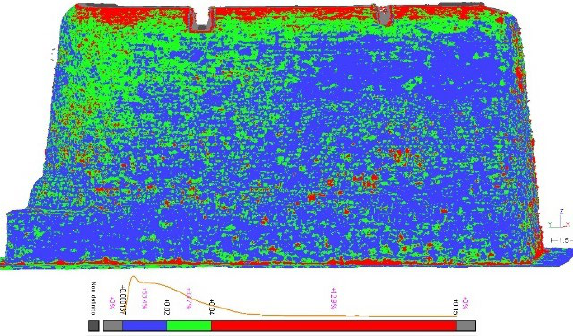
Figure 13. Deviation maps from point clouds comparison between UAV-based and close-range 3D